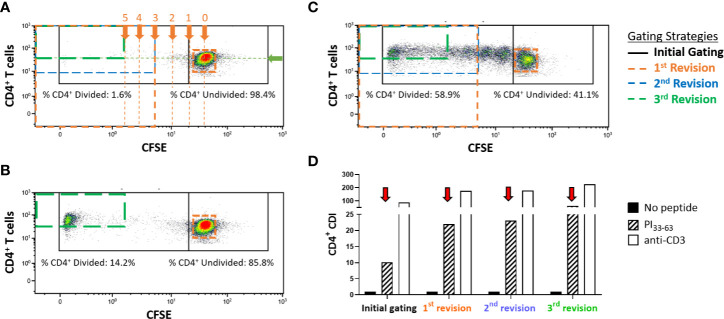
Representative flow cytometry plots displaying gating strategies to assess CD4+ T-cell proliferative responses in freshly isolated PBMC measured with the CFSE proliferation assay after a 7-day incubation. Cells were first gated on CD4+CD3+ live single cells. (A) PBMC that were incubated without antigen (no-peptide negative control), (B) PBMC incubated with PI33-63, (C) PBMC incubated with anti-CD3 (positive control). Proliferating cells are gated (left gates). In this example, 14.21% of CD4+ T-cells divided in response to incubation with PI33-63 when the 3rd revised gating strategy was applied. Gates are set mathematically on the no-peptide condition and applied to all other conditions. The “initial gating” capturing the CFSE(undivided) cells on the right, and CFSE(divided) cells on the left is shown in black. The arrows labeled “0, 1, 2, 3, 4, 5” indicate the numbers of cell divisions, equivalent to MFI divided by 1, 2, 4, 8, 16, 32. The green arrow indicates the MFI of CD4, expressed by the CFSE(undivided) population. (D) Revised gating strategies reduced capture of the no-peptide background proliferation and resulted in a higher CDI for all antigen-stimulated conditions. CDI, Cell division index.